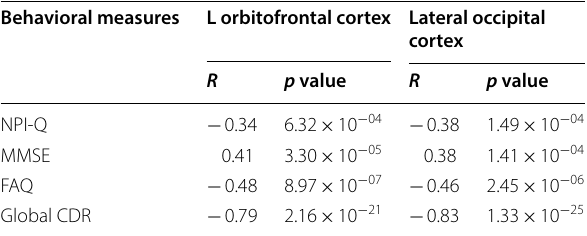
Table 3 Correlation value ( R ) and corresponding p value for the association between behavioral measures and middleman power of L OFC and LOC Behavioral measures